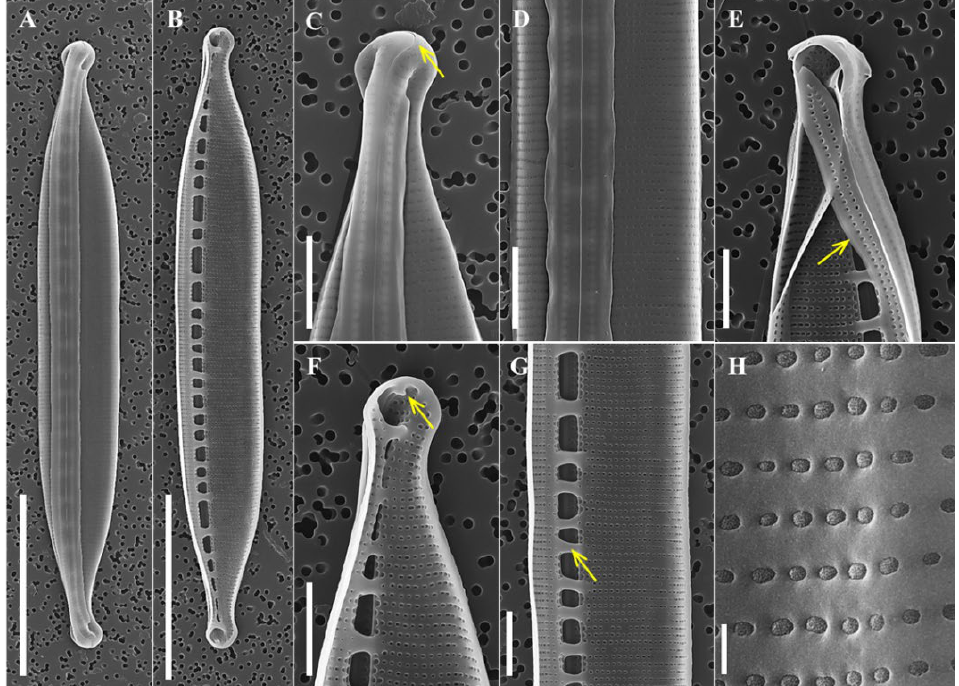
Figure 11. SEM of Nitzschia inclinata sp. nov. taken from holotype population (AG9004): ( A , B ) scale bar = 10 µm; ( C – G ) scale bar = 2 µm; ( H ) scale bar = 200 nm; ( A ) external view of whole valve; ( B ) internal view of whole valve; ( C ) external view of valve apex, terminal fissure (arrow); ( D ) external view of valve middle; ( E ) internal view of valve apex with girdle band (arrow); ( F ) internal view of valve apex, helictoglossa (arrow); ( G ) internal view of valve middle, fibulae (arrow); ( H ) external view of areolae.